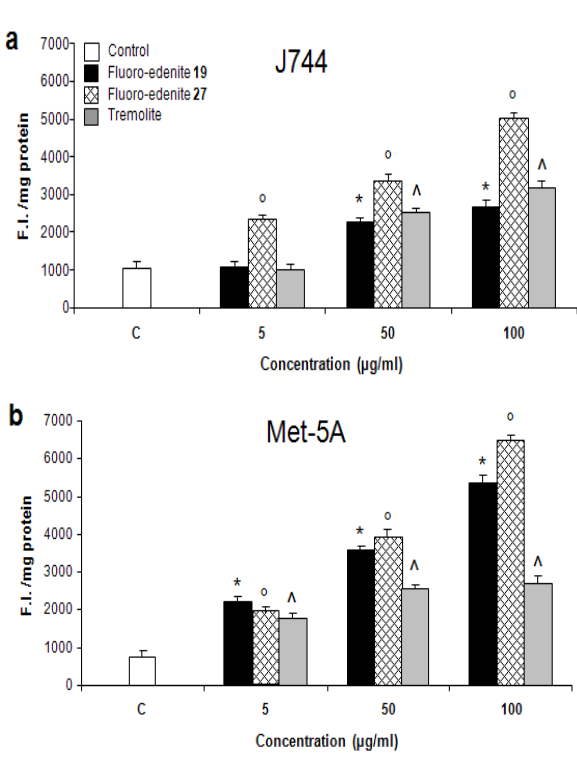
Figure 3: Detection of ROS formation in J774 (a) and Met-5A (b) cells measured by a fluorescence assay. The values, expressed as fluorescence intensity units (F.I.)/mg of proteins, are the mean ± SEM of three experiments performed in triplicate. All values with P<0.01 were considered significantly different. *°^ denotes significant differences versus untreated control.